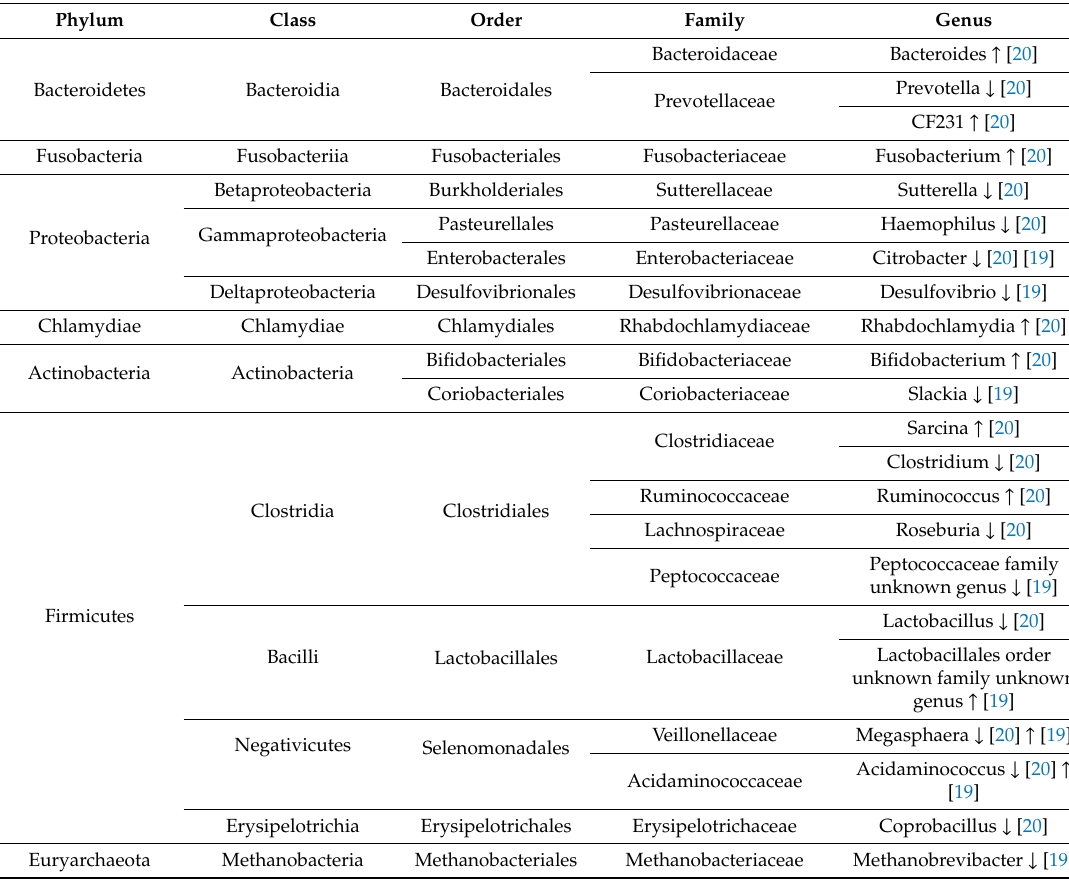
Table 6. Gut microbiome alterations in